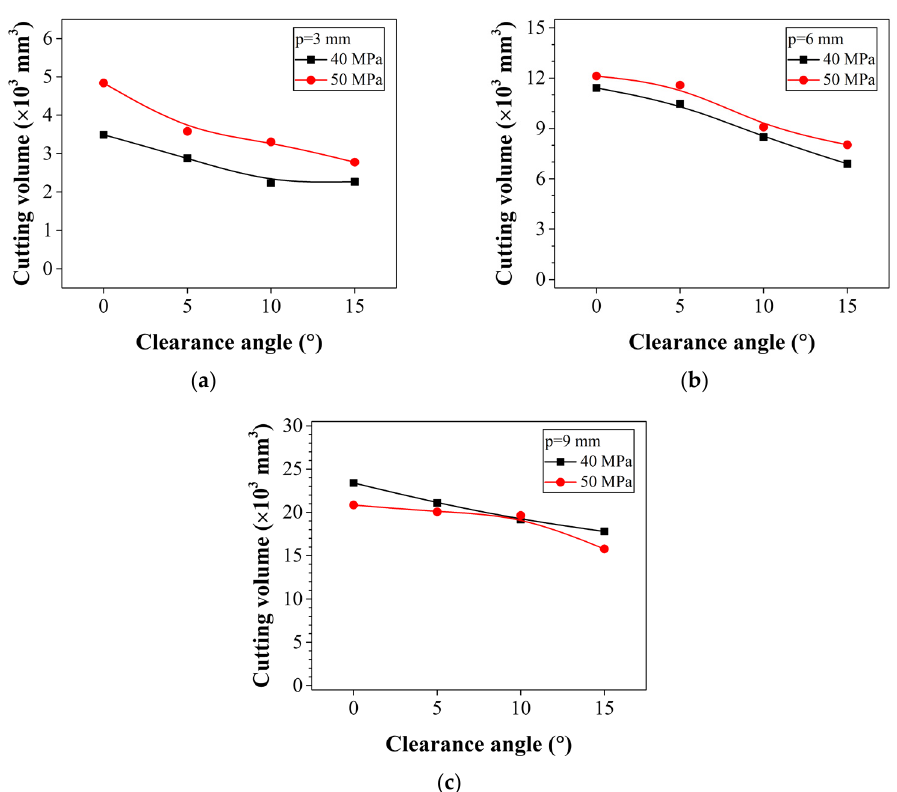
Figure 15. Relationship between the cutting volume and clearance angle for depths ( p ) of: ( a ) 3 mm, ( b ) 6 mm, and ( c ) 9 mm. Table 5. Cutting volume and specific energy for various clearance angles.